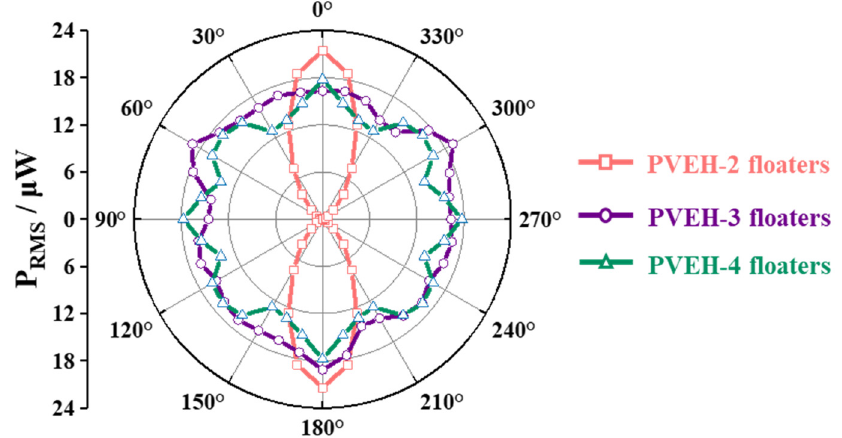
Figure 9. The angular response of PVEH with different numbers of floating blocks on the horizontal plane at a = 0.03 g, H = 23 mm, L = 0 mm.